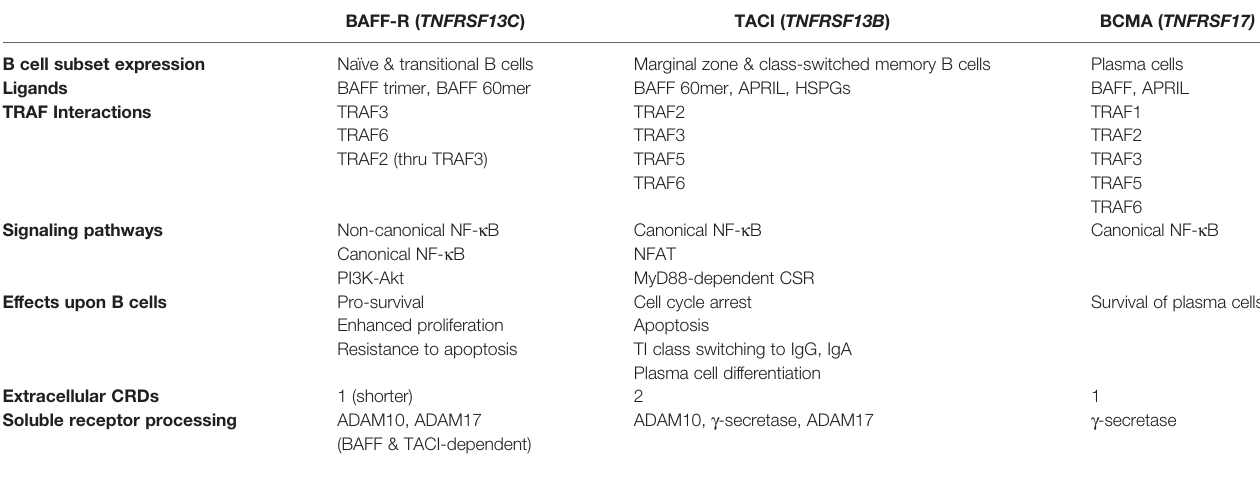
TABLE 1 | Important characteristics of the receptors for